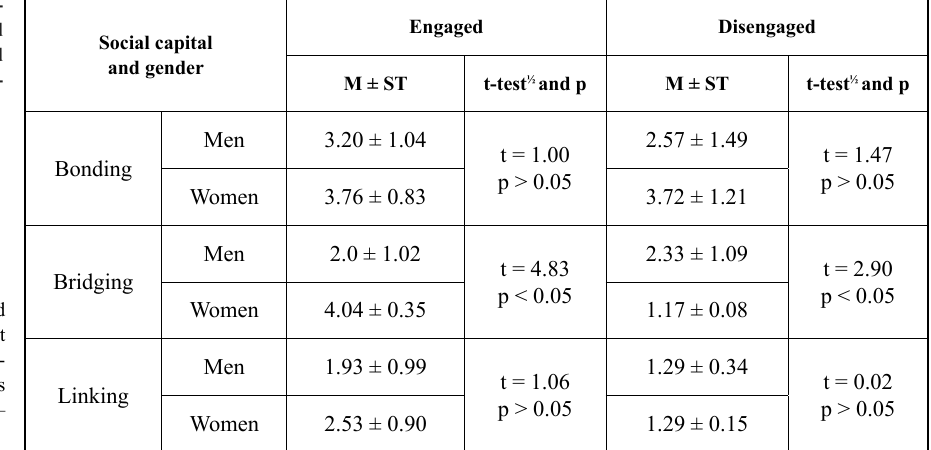
Table 2. Values of the acti- vity estimates of men and women participating and non-participating in com- munity groups